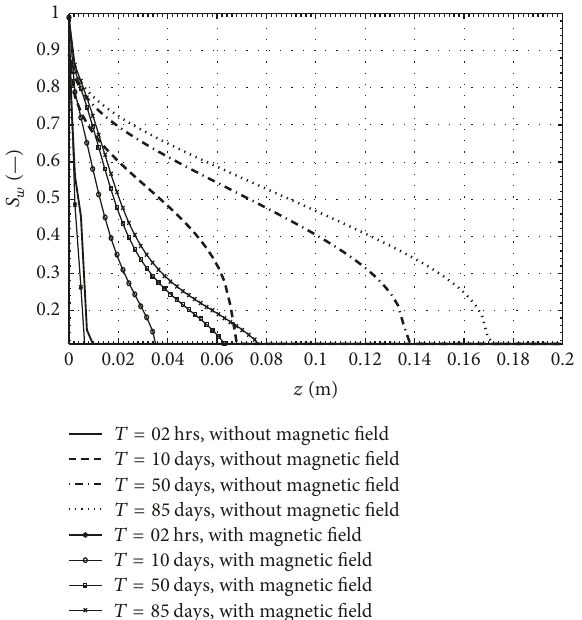
Figure 9: Porosity variation against core length with and without magnetic field effect for various values of imbibition time: magnet is placed on the right side of the core.